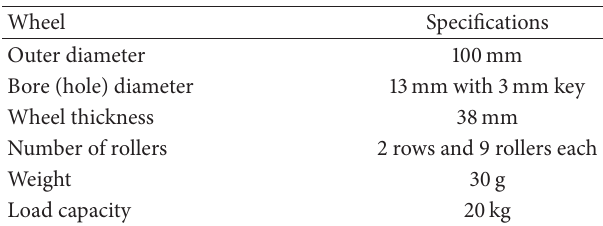
Table 1: Specifications of omniwheel.